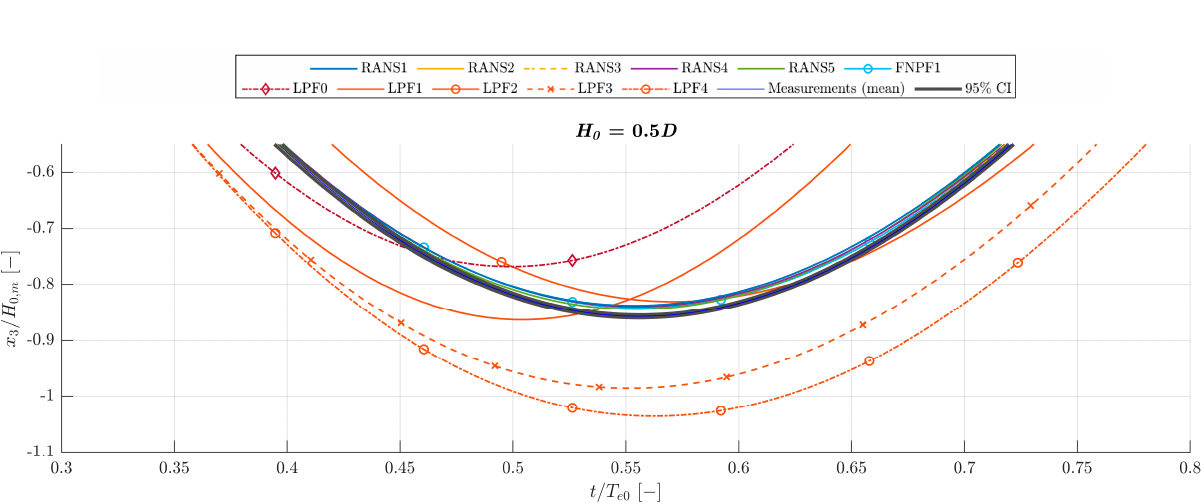
Figure 23. Comparison of physical and numerical test results at the first trough.